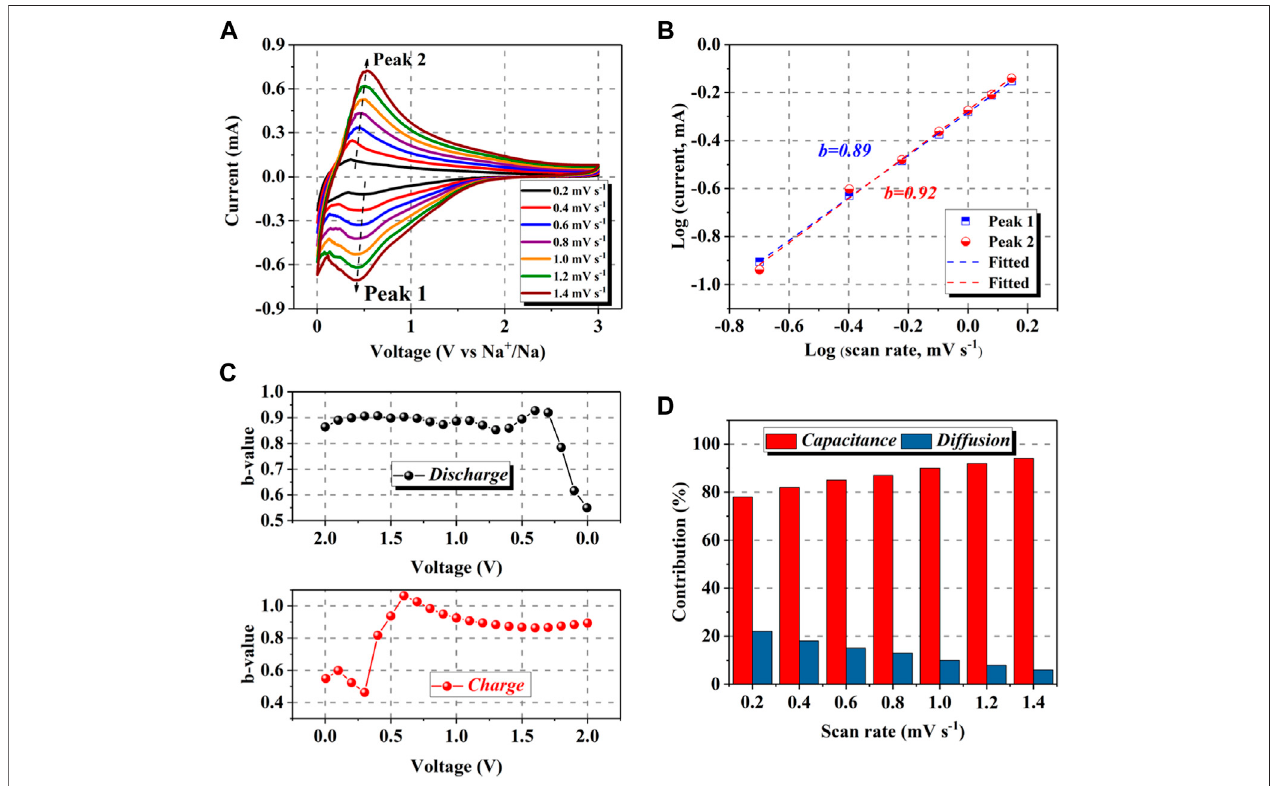
FIGURE 4 | CV curves (A) ofNSC-600 electrode at the scan rate of 0.2 – 1.4 mV s − 1 . The plots of Log( i ) versus Log( v ) to obtain the b values ofthe marked peaks in the CV curves (B) . The variations of b values upon discharging and charging (C) . Contributions at various scan rates from capacitance and diffusion (D) .